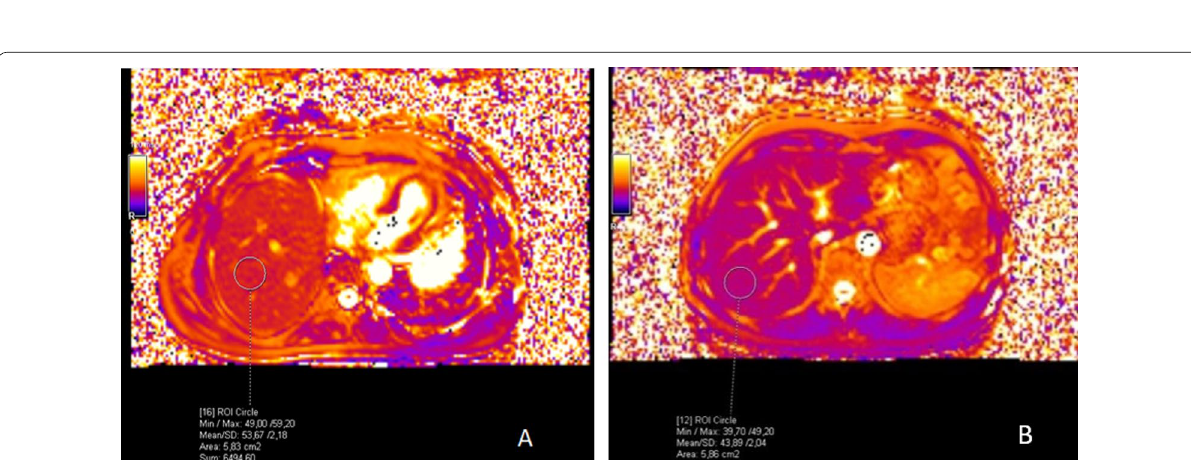
Fig. 5 T2 mapping images of the same patients in Fig. 4 demonstrate a T2 relaxation time of 53 ms in the patient with SOS ( A ) and 44 ms in the control patient ( B )